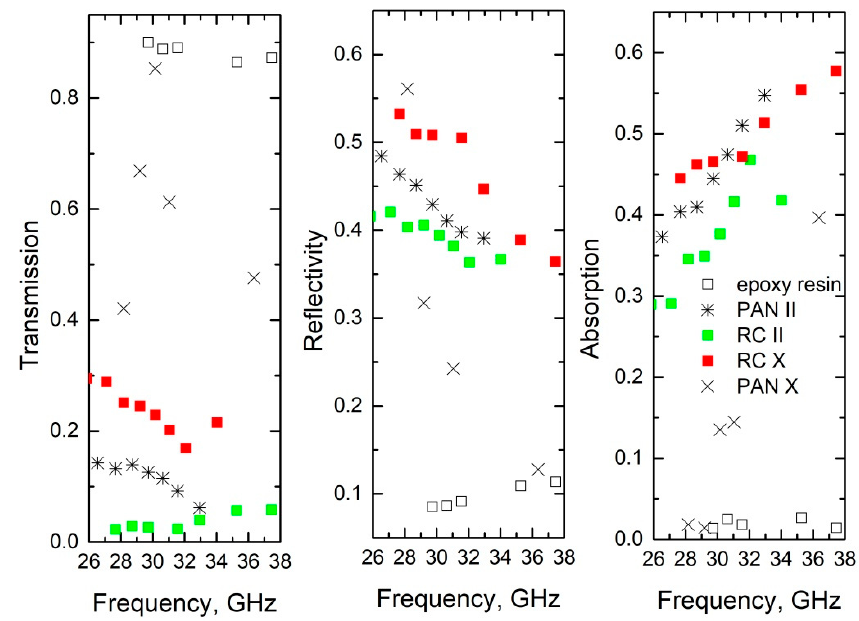
Figure 6. Reflection, transmission, and absorption of carbon fiber felt composites.